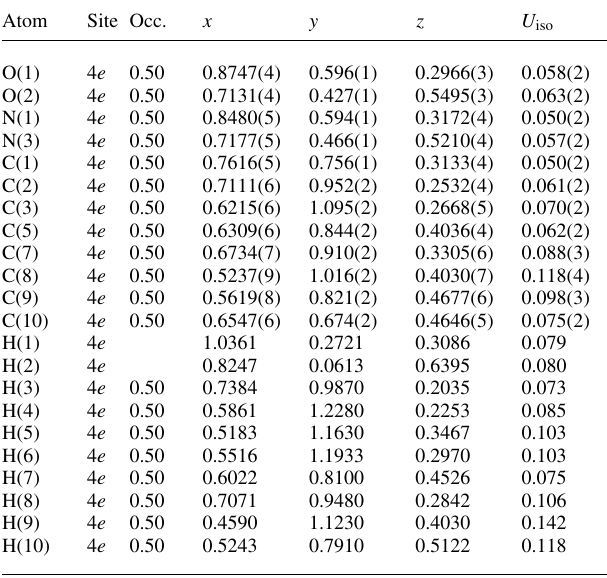
Table 2. Atomic coordinates and displacement parameters (in Å 2 ) .